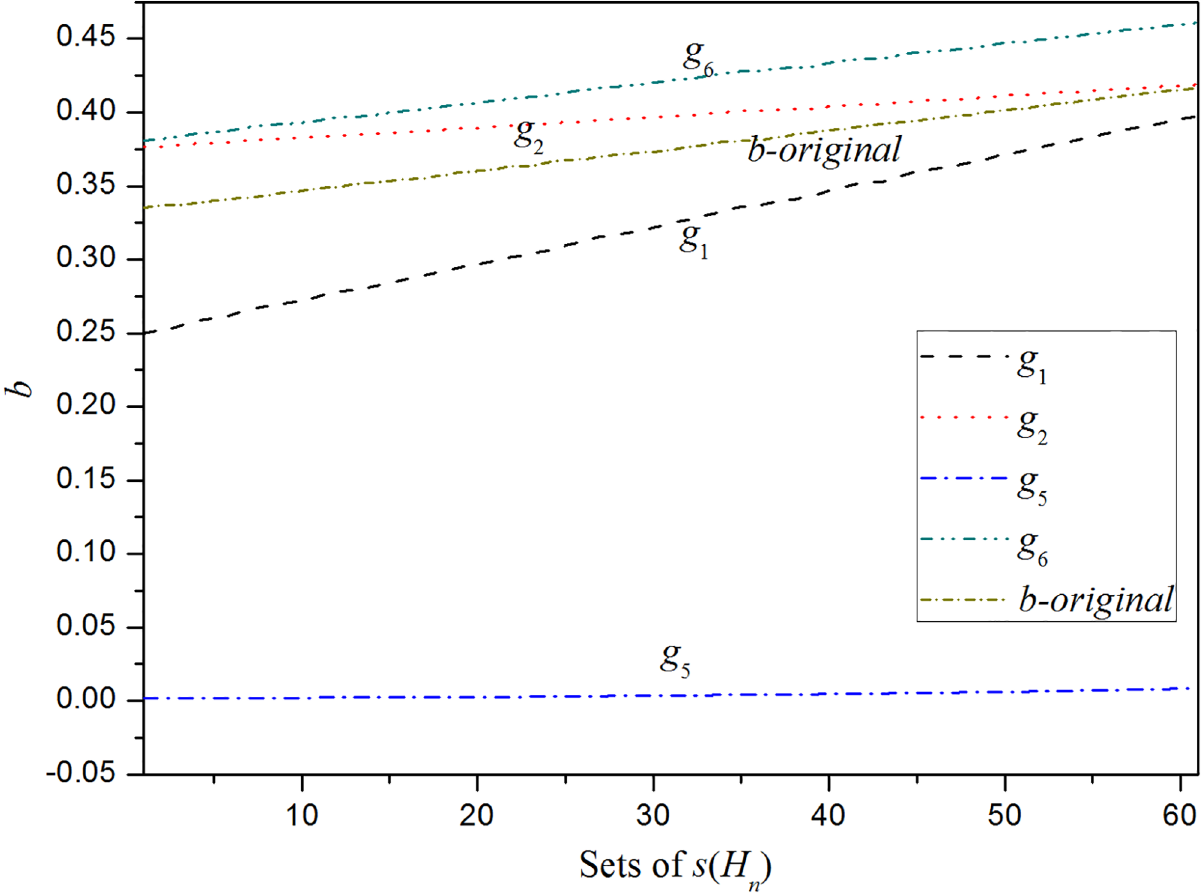
Fig 3. The comparison of the combinations of b j generated by using the four sets of functions for the manager selection problem.